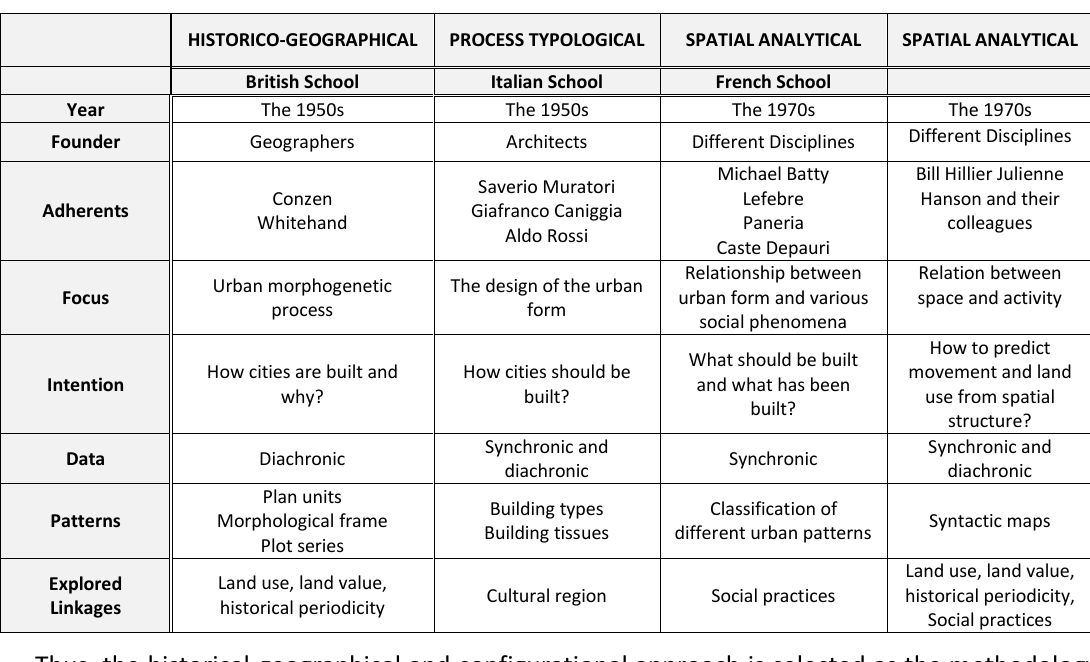
Table 2 Similarities and differences among three schools, compiled by the author.